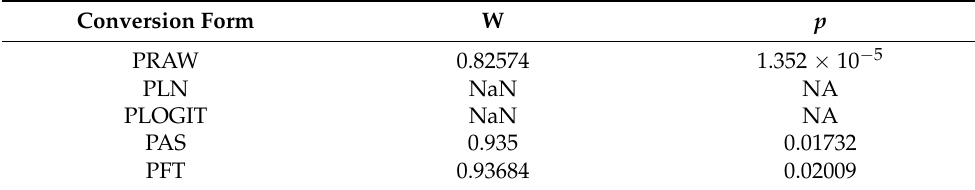
Table 3. Normal distribution test for the normal rate and the different conversion of the normal rate in Trichinella spiralis infection in domestic pigs in